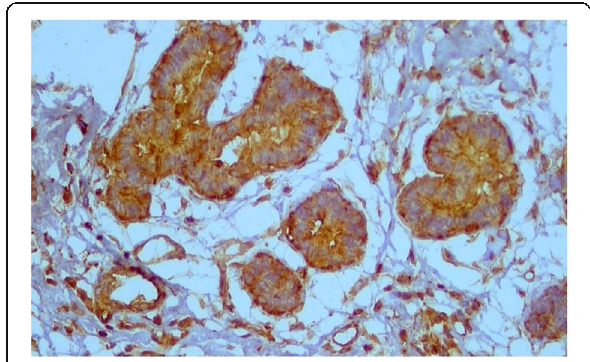
Fig. 1 Intense RRM2 expression in cancer breast ×200